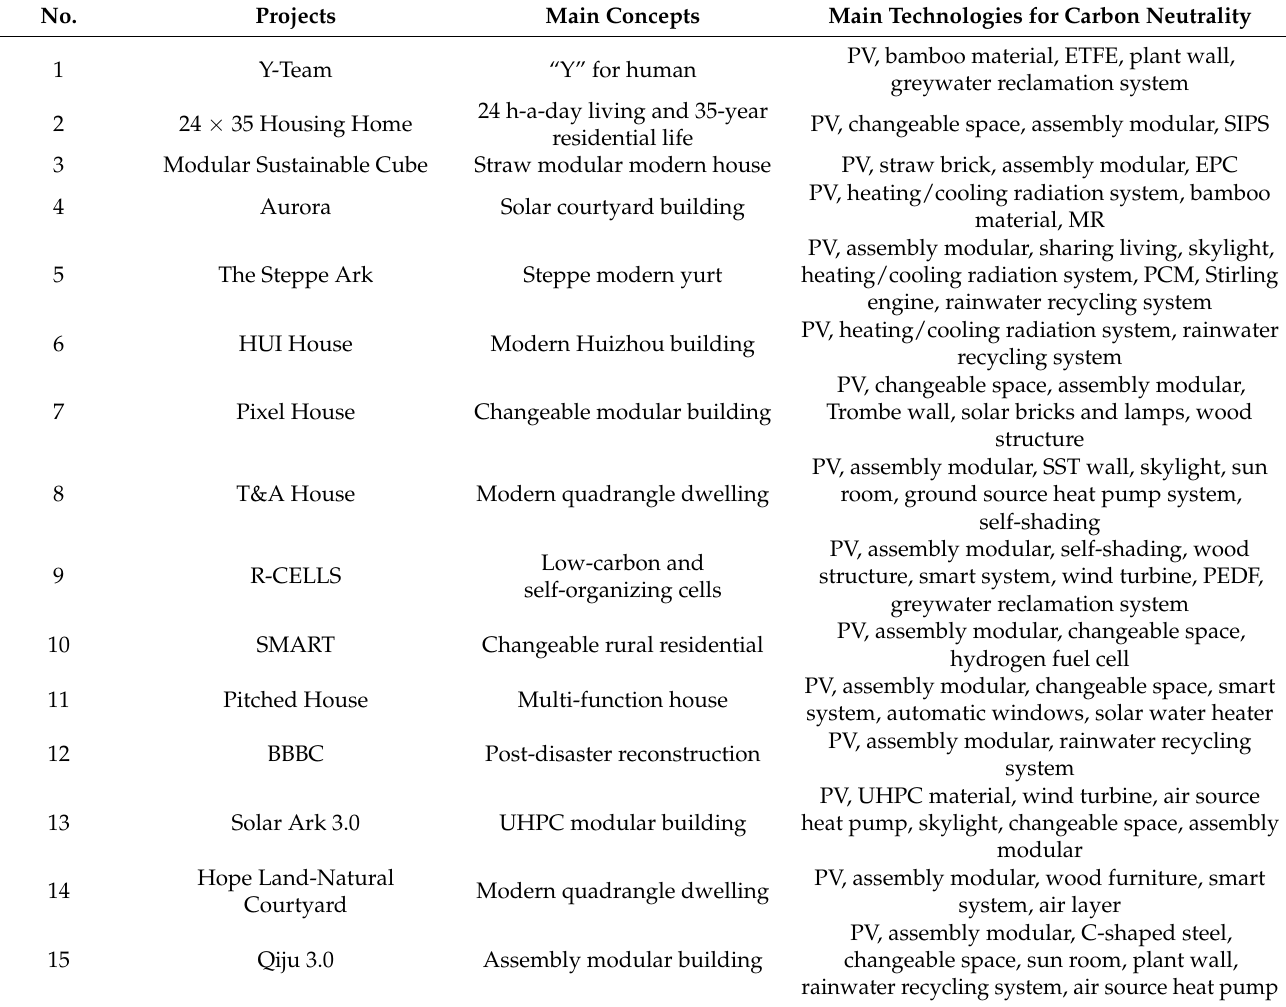
Table 4. Main concepts and technologies of the Third SDC buildings for carbon